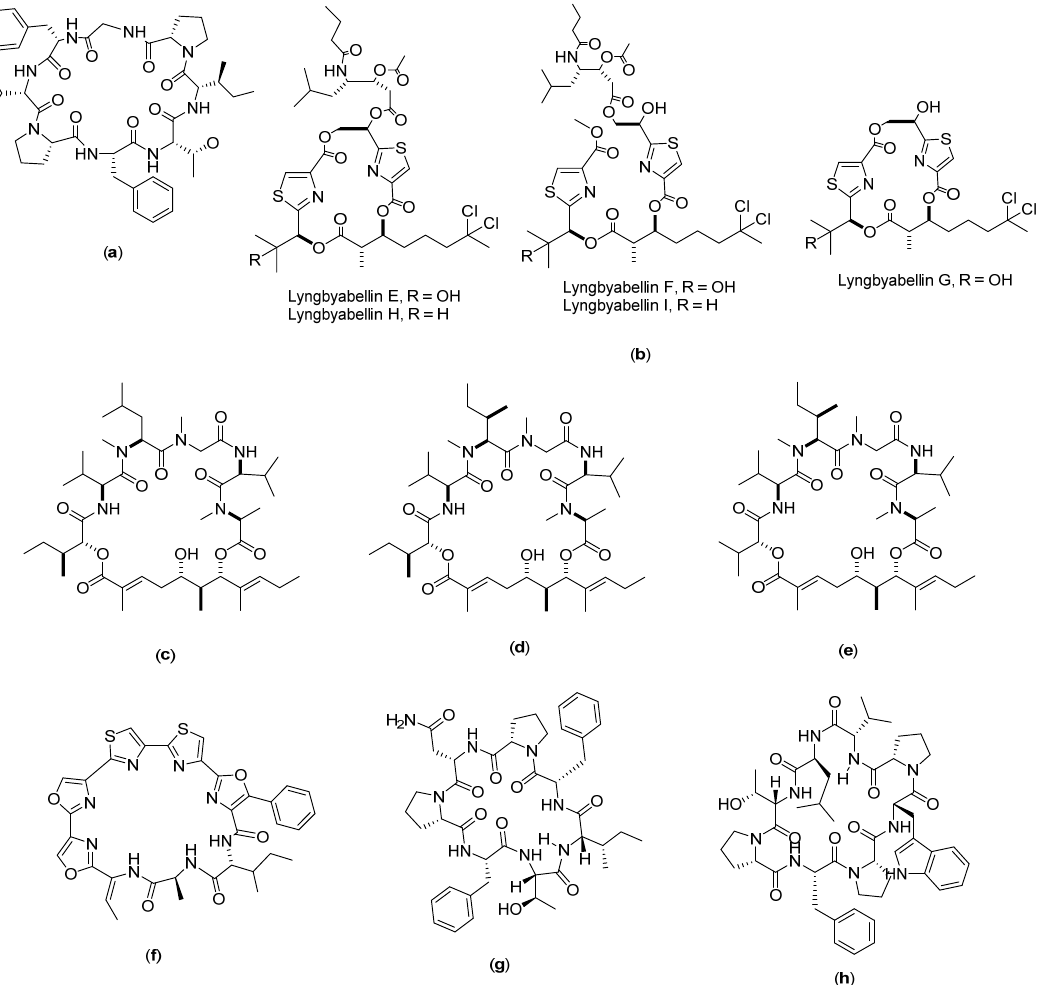
Figure 5. Structure of: ( a ) Psammosilenin; ( b ) Lyngbyabellin; ( c ) Aurilide A; ( d ) Aurilide B; ( e ) Aurilide C; ( f ) Urukthapelstatin A; ( g ) axinellin A; and ( h ) axinellin B.